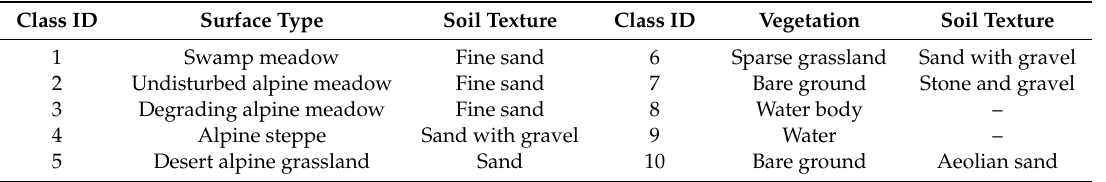
Table 1. Ground surface type and associated soil type in the study area